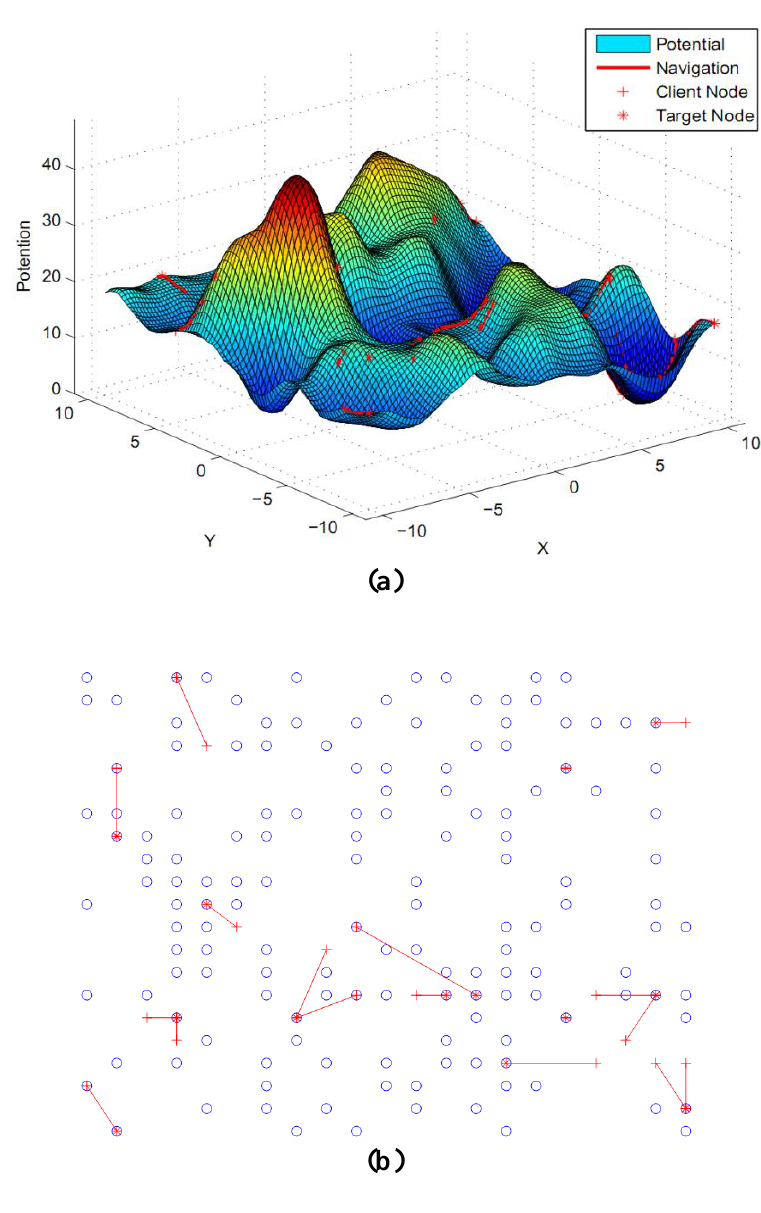
Figure 9. Navigation results of several users. (a) Guided to the regions; (b) Topology of the